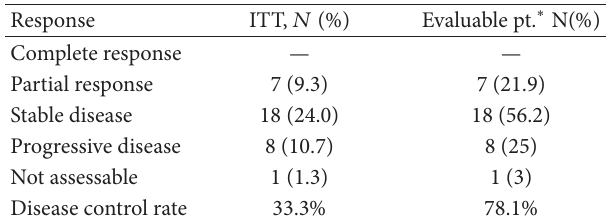
T 3: Adverse events during sorafenib therapy. Adverse